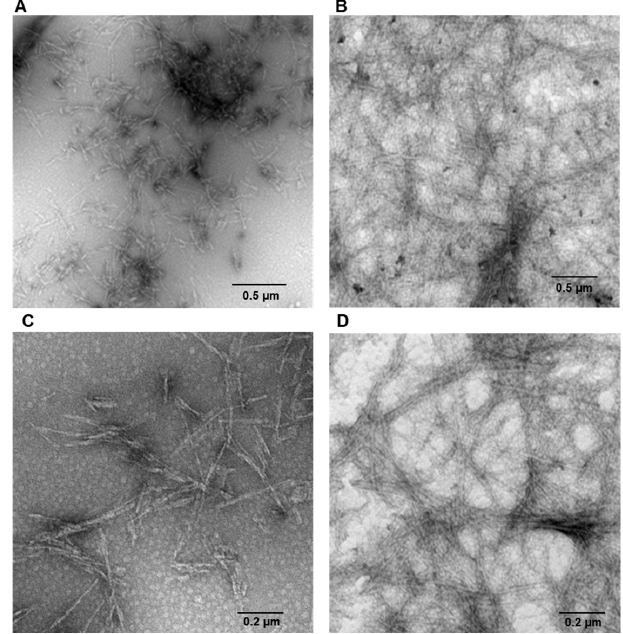
Figure 2. Amyloid fibrils formation in human insulin monitored by TEM. Protein was analyzed after 24 h of incubation in aggregating conditions at pH 7.0 ( A , C ) and pH 1.8 ( B , D ). Experimental details are described in the Materials and Methods section.